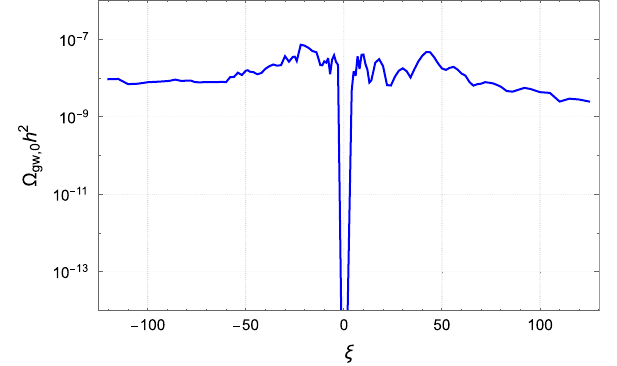
Fig. 5 The total GW energy density today as a function of